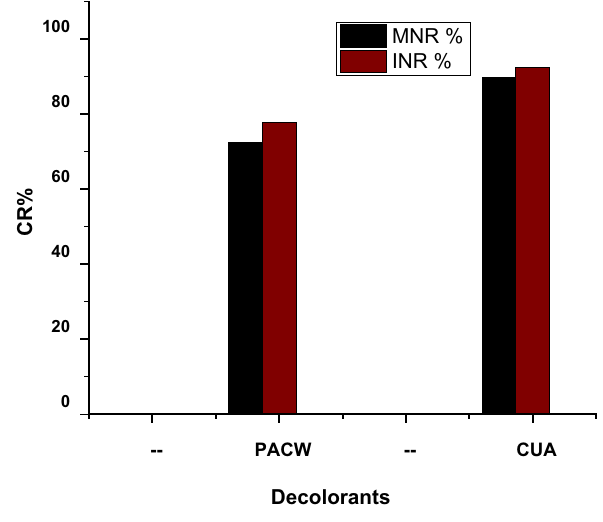
Fig. 7 Data showing the effect of IN and MN for both PACW and CUA